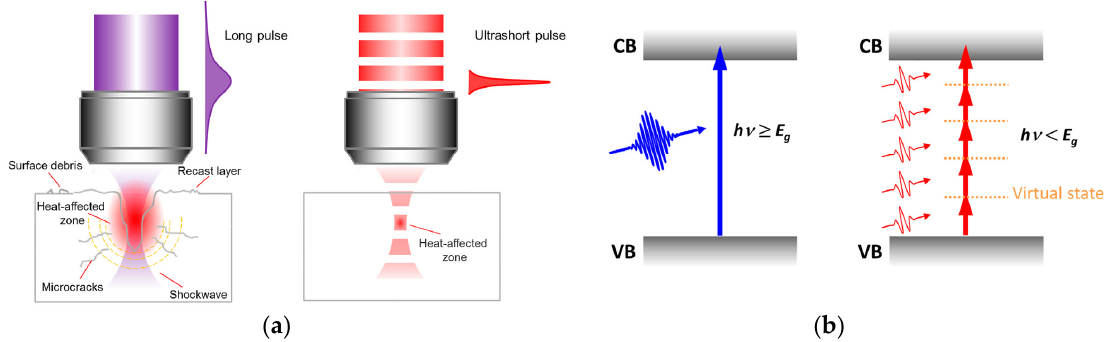
Figure 1. ( a ) Difference in the treatment effects in the case of long and ultrashort pulses for a transparent material to the laser wavelength; ( b ) effect of the single photon absorption occurring only with an energy larger than the semiconductor/dielectric bandgap compared to the multiphoton absorption of sub ‐ bandgap photons [17] (CC BY 4.0).